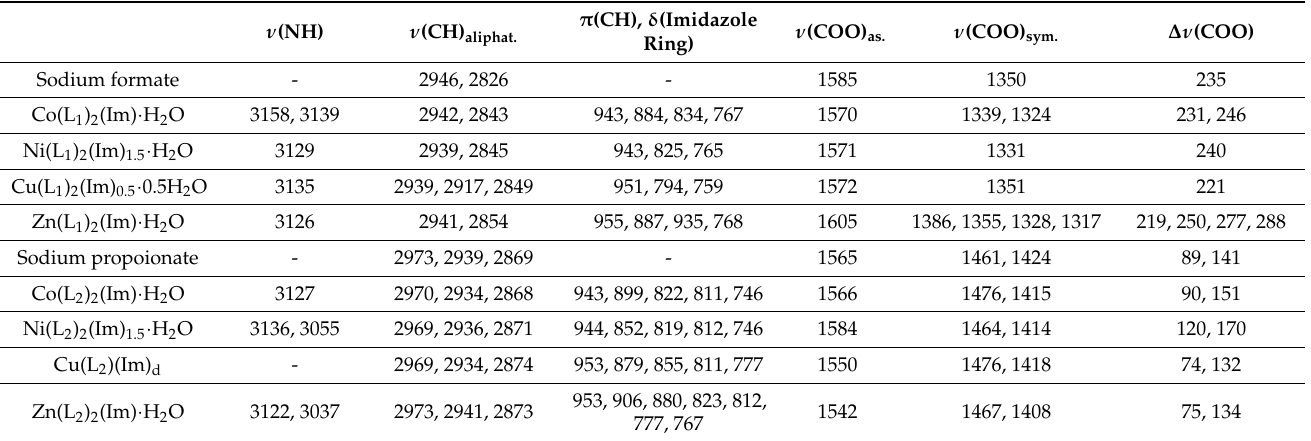
Table 3. FTIR modes (cm − 1 ) observed for studied M(II) formate- or propionate-imidazole complexes, and for sodium formate and sodium propionate.